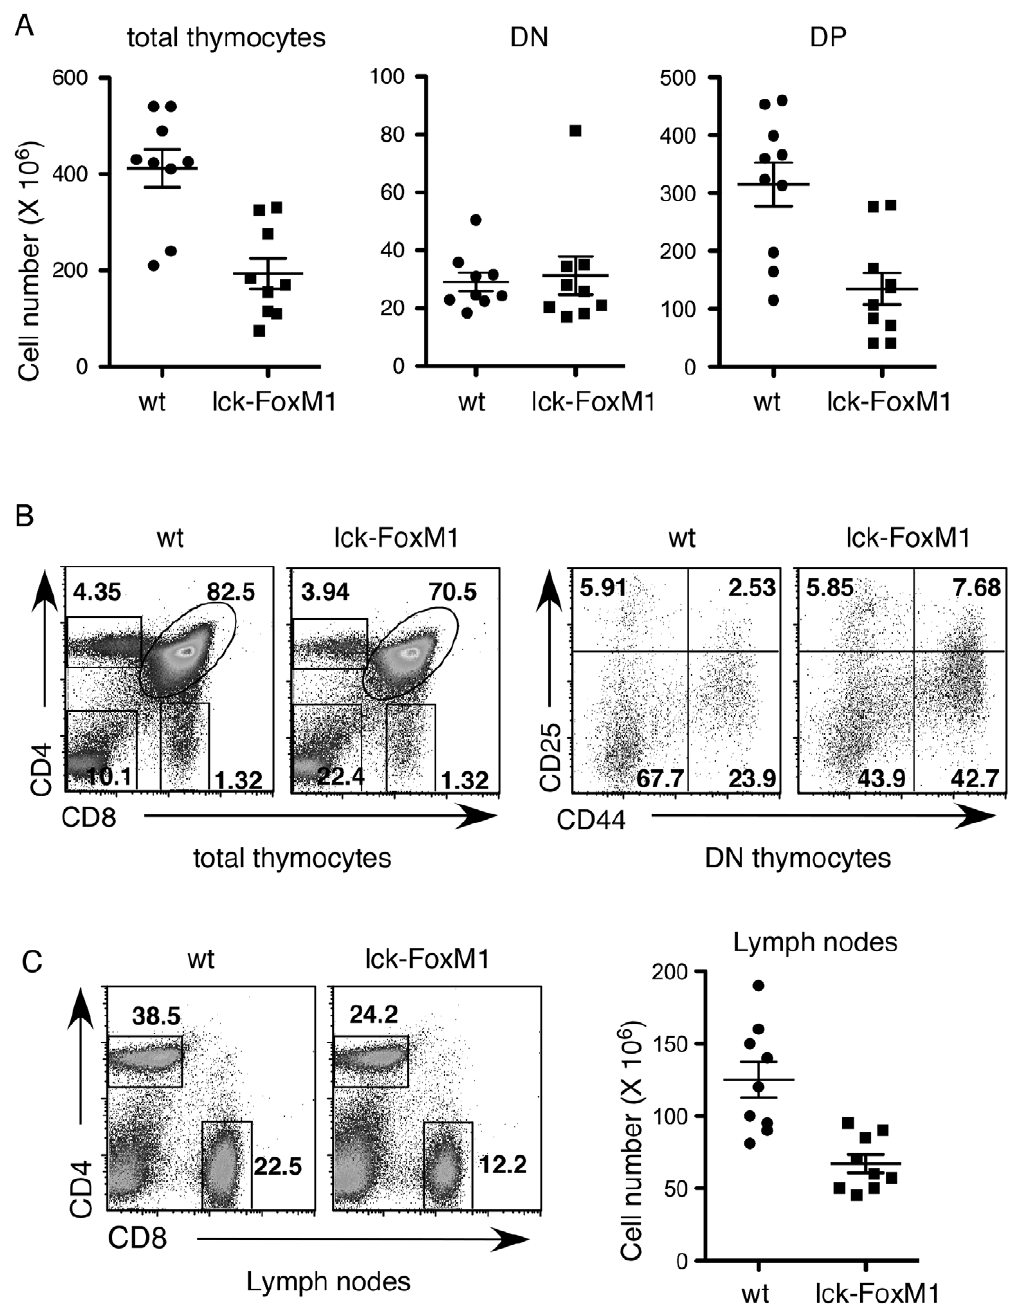
Figure 1. Characterization of lck-FoxM1 mice. (A) The total number of thymocytes, double negative (DN) cells, and double positive (DP) cells from each mouse are depicted as a box or a circle ( n =9). The average number of the total thymocytes (X 10 6 ) are 412 6 117 for wild-type mice and 193 6 95 for the lck-FoxM1 mice (p , 0.05). The average number (X 10 6 ) for DN thymocytes are 29.1 6 9.7 for wild-type mice and 31.2 6 19.9 for lck- FoxM1 mice. For DP thymocytes, the average number (X 10 6 ) is 315 6 119 for wild-type mice and 134 6 86 for lck-FoxM1 mice (p , 0.05). (B) Representative plots of CD4 versus CD8 profiles of total thymocytes and CD44 versus CD25 profiles of gated DN thymocytes are shown. (C) CD4 versus CD8 profiles and the total number of cells in lymph nodes are shown here. Right panel: Each box or circle represents one mouse ( n =9). The average number of the total lymph nodes cells (X 10 6 ) are 125 6 37 for wild-type mice and 66.9 6 18.9 for the lck-FoxM1 mice (p , 0.05).